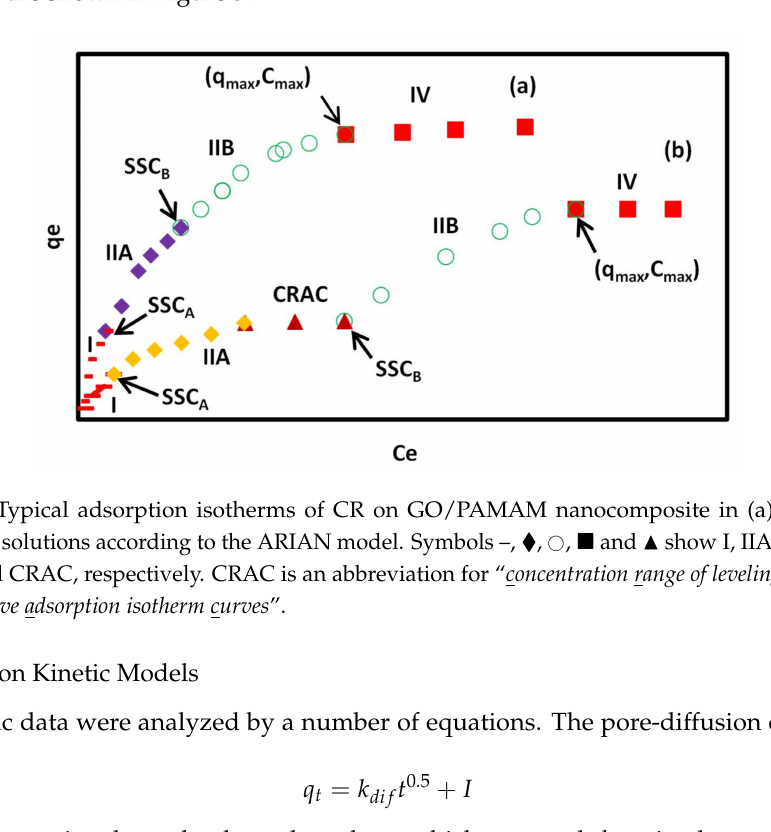
, (cid:4) and (cid:78) show I, IIA, IIB, and IV (cid:35)